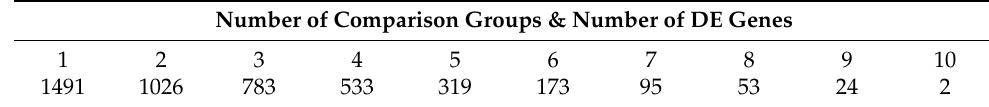
Table 4. Number of differentially expressed genes present in grouped comparisons (1 = only one comparison, 2 = gene DE in 2 comparisons,